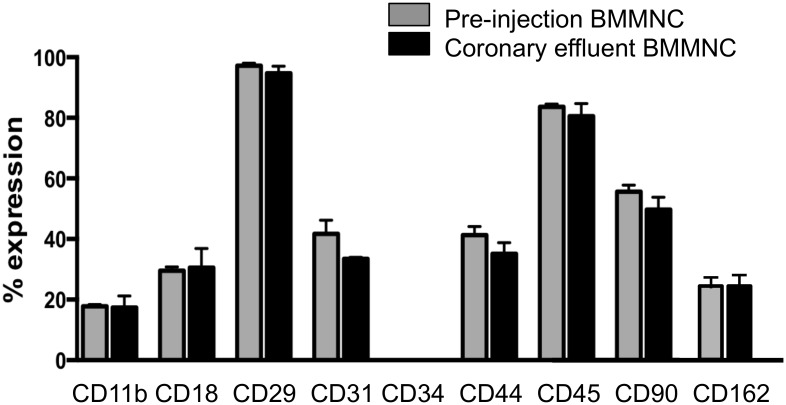
Relationship of cell-surface proteins and retention of BMMNC.The expression profiles of cell-surface proteins, including integrin and selectin ligand, on pre-injection BMMNC and BMMNC in the coronary effluent (collected over the five-minute duration post-IC injection of 8x106 BMMNC) were compared by flow cytometric analysis. No difference was found in any of the surface proteins investigated (n = 6 hearts were studied, unpaired T-test), suggesting that these cell-surface proteins are not critical for retention in normal hearts.